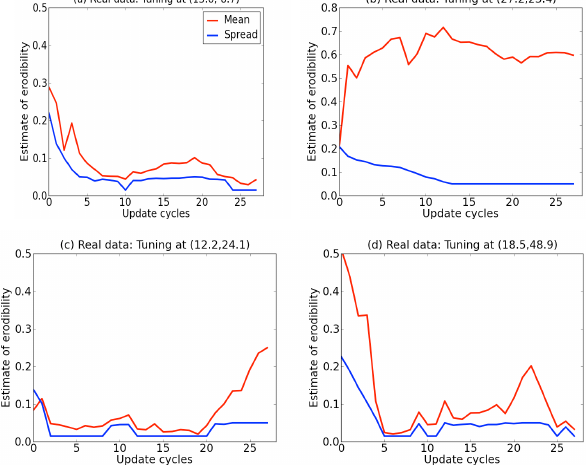
Fig. 9. Each panel shows the mean and spread of the erodibility at 4 different grid points for the real data experiment. The latitude and longitude of the point is mentioned in the title of each panel.